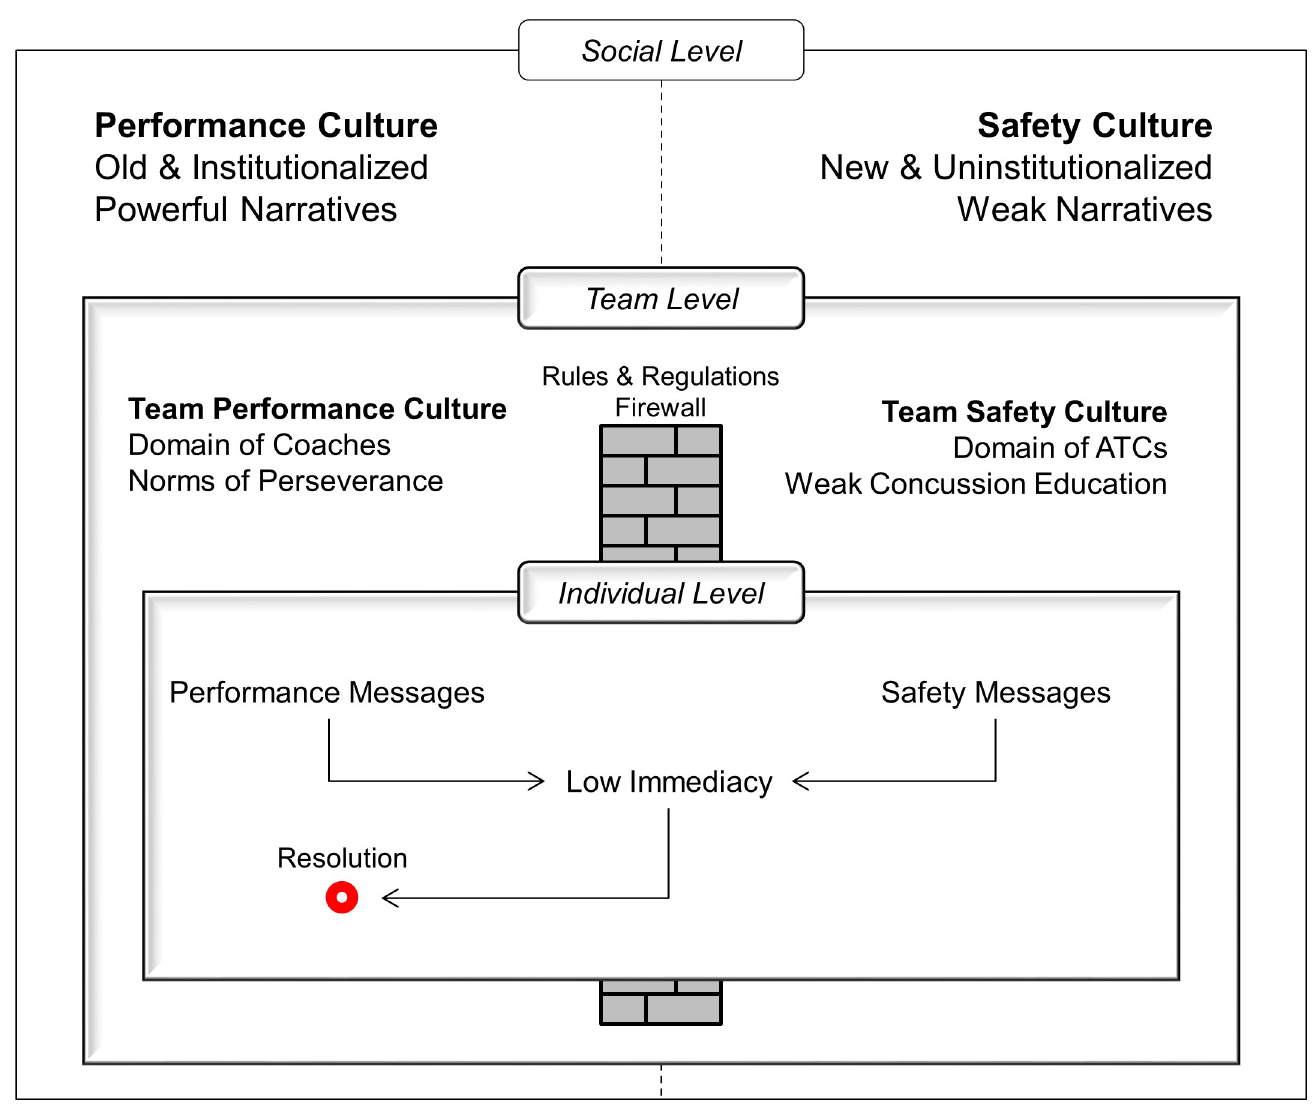
Fig 2. Influences of three socio-ecological levels on athlete reporting